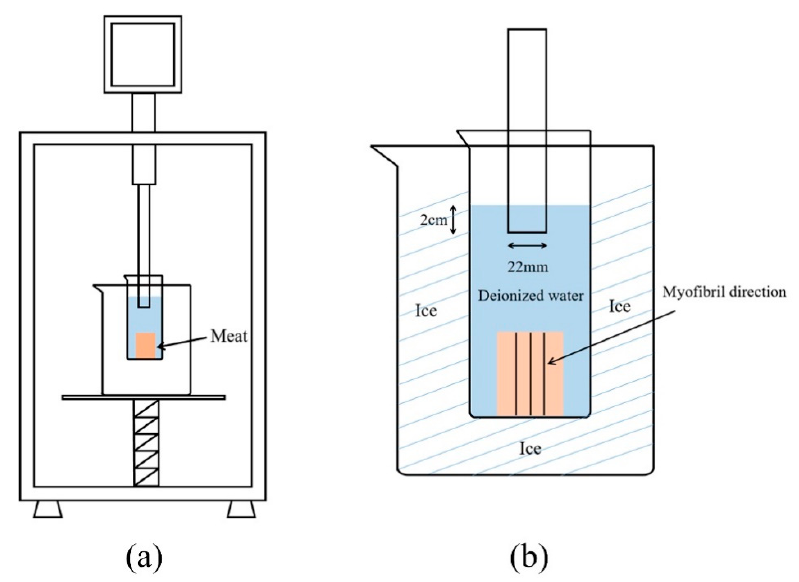
Figure 1. The schematic diagram of the ultrasound process, ( a ): Front view of ultrasound process; ( b ): The front detail of the ultrasound process.